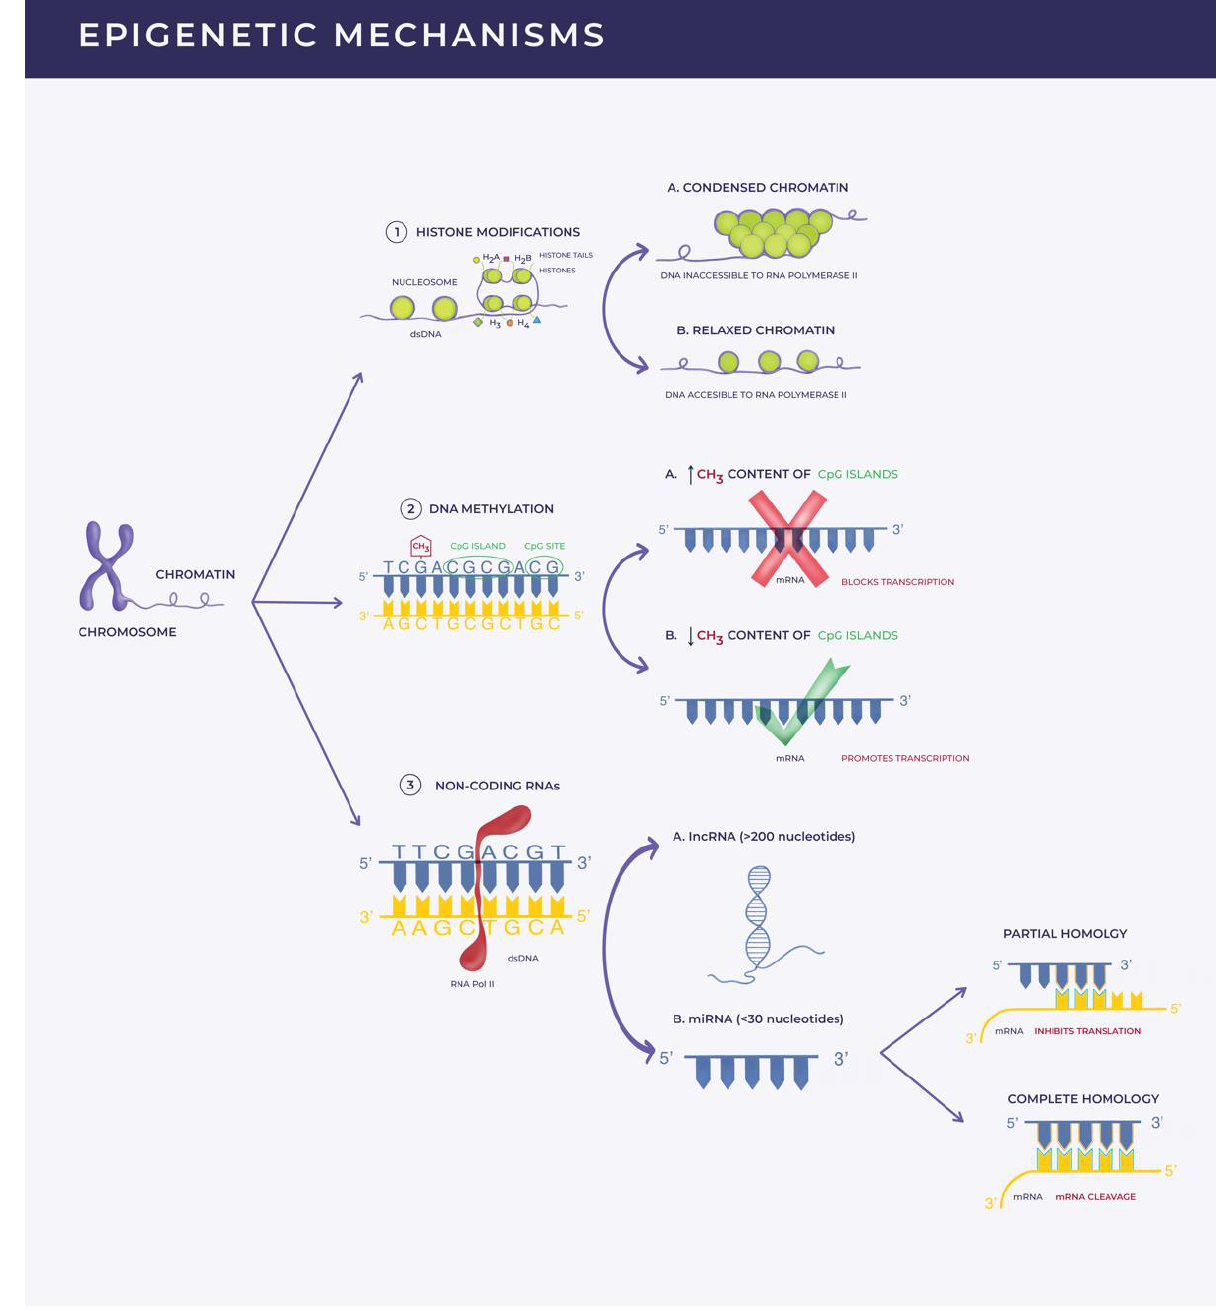
Figure 1. Illustration of epigenetic mechanisms. This figure is a schematical representation of the epigenetic mechanisms that modulate gene expression: (1) Histone modifications refer to post-translational modifications of the histone proteins leading to conformational changes that make DNA more or less accessible to RNA polymerase II (RNA POL II); (2) DNA methylation is an enzyme-mediated process consisting of the addition of a methyl (CH3) group to the 5-carbon of the cytosine ring from a CpG site. Clusters of CpG sites form a CpG island. The methylation status of a CpG island located in the promotor region of a gene can either lead to gene silencing if highly methylated or active gene transcription if slightly methylated; (3) Non-coding RNAs (lncRNAs and miRNAs) are functional RNA fragments transcribed from the DNA by RNA Pol II but unable to be translated into proteins. LncRNAs possess diverse functions, such as the capacity of altering mRNA splicing or recruiting chromatin remodeling proteins and transcription factors. MiRNAs have the ability to bind post-transcriptionally to a complementary sequence from a target mRNA and induce gene silencing. Depending on the degree of homology they can either inhibit transcription or induce mRNA cleavage.